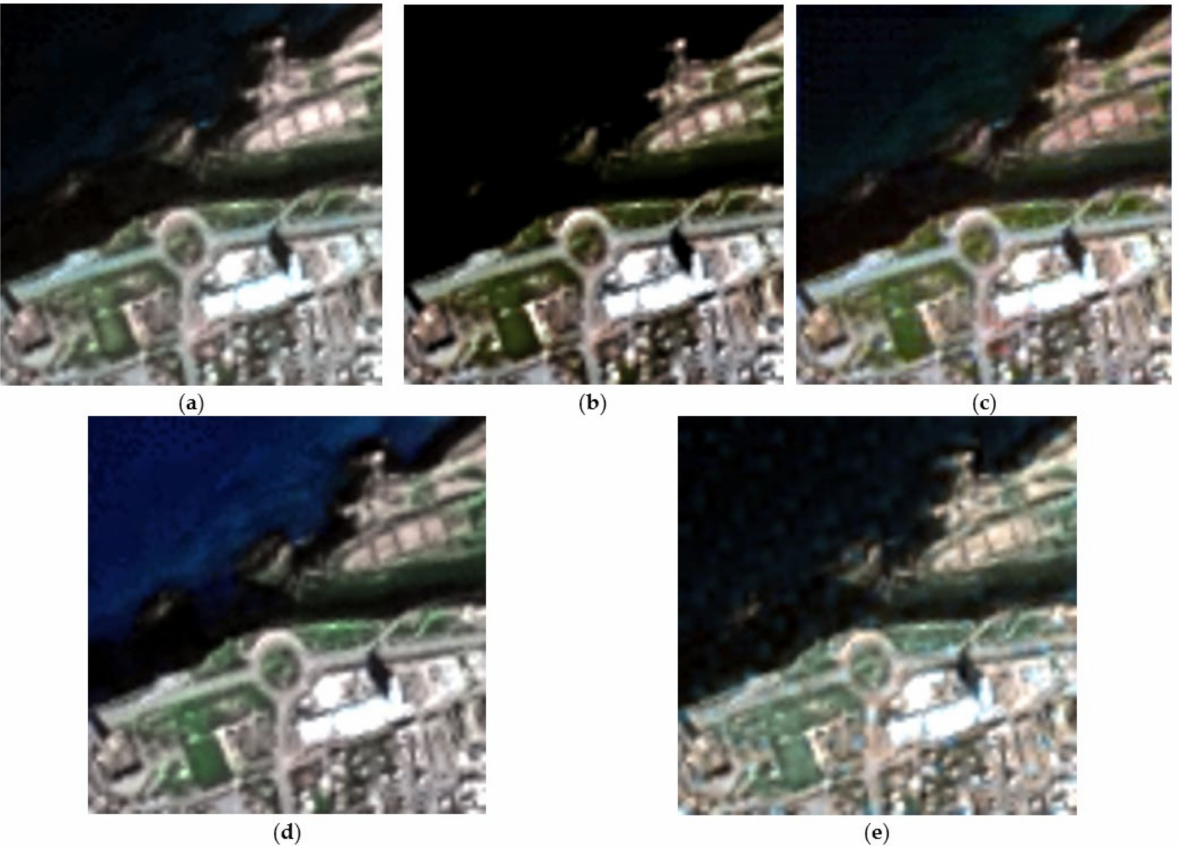
Figure 8. True-color image composite for fusion products derived for the real dataset. ( a ) Obtained HSB-SV sharpened hyperspectral image; ( b ) Obtained HMF-IPNMF sharpened hyperspectral image; ( c ) Obtained HySure sharpened hyperspectral image; ( d ) Obtained CNMF sharpened hyperspectral image; ( e ) Obtained FuVar sharpened hyperspectral